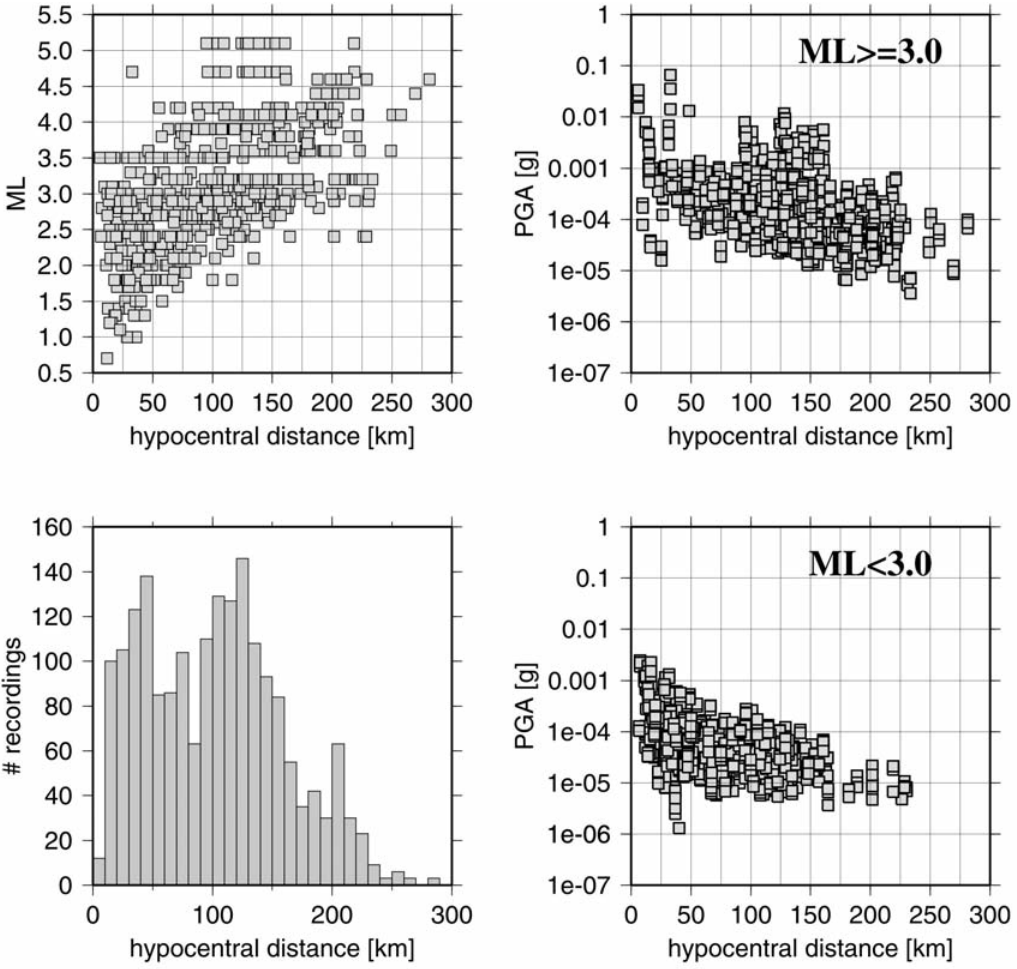
Figure 7. RAIS dataset from June 2006 to June 2010. Left: recordings represented as functions of local magnitude (top) and hypocenter distance (bottom). Right: maximum peak ground acceleration of each record, as M